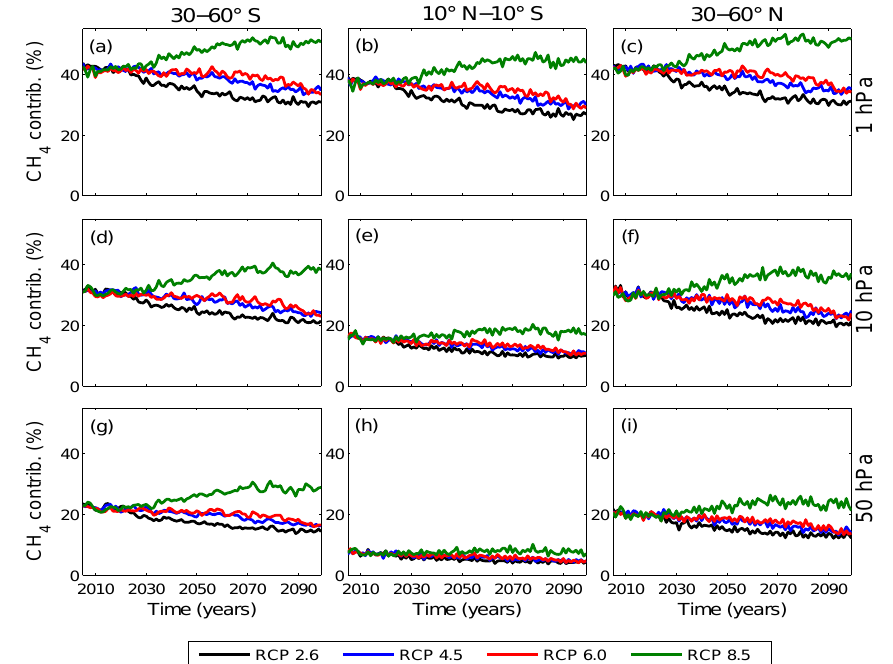
Figure 9. Percentage contribution of methane to SWV in the four RCP simulations for the regions shown in Fig. 6. Methane contributions were calculated as for Fig.